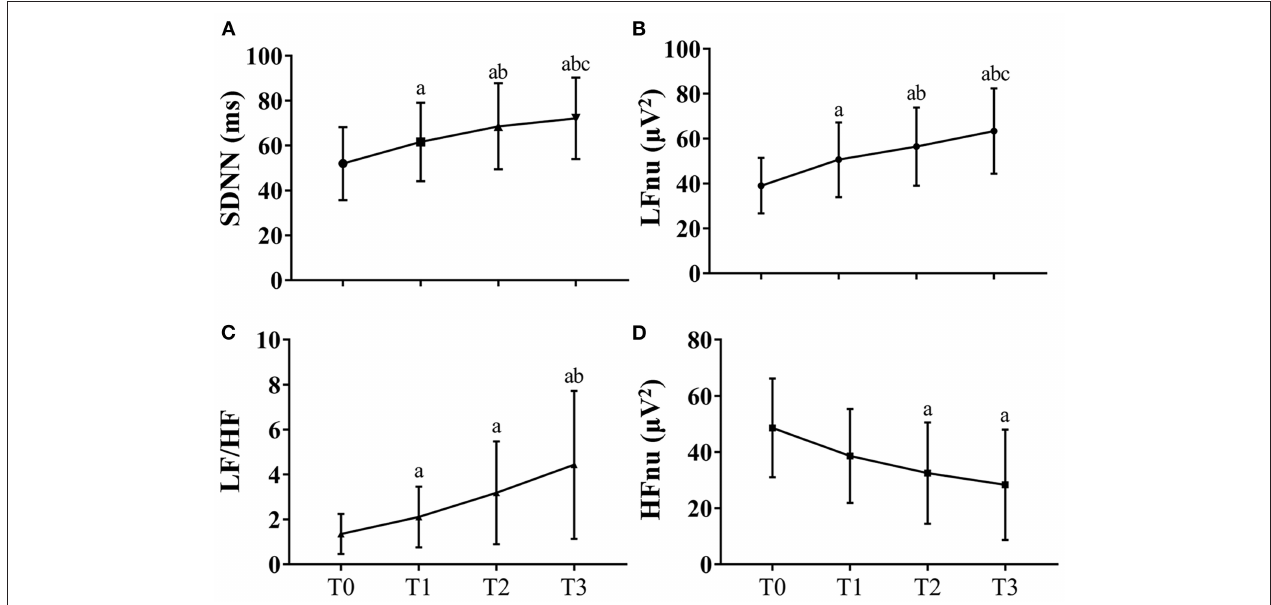
FIGURE 2 | HRV fluctuations during the driving task for all participants. Due to missing data of HRV of two participants, the data at these two timepoints were the results of data analysis of 30 participants. The error bars in this figure represent mean ± SD. (A) The variations of SDNN for HRV. (B) The variations of LFnu for HRV results. (C) The variations of LF/HF for HRV results. (D) The variations of HFnu for HRV. HF indicates high frequency; HFnu, normalization of HF power by the formula: HF / (LF + HF) * 100; HRV, heart rate variability; KSS, Karolinska Sleepiness Scale; LF, low frequency; LFnu, normalization of LF power by the formula: LF / (LF + HF) * 100; SDNN, standard deviation of the NN intervals. a P < 0.05 vs. T0; b P < 0.05 vs. T1; c P < 0.05 vs. T2.